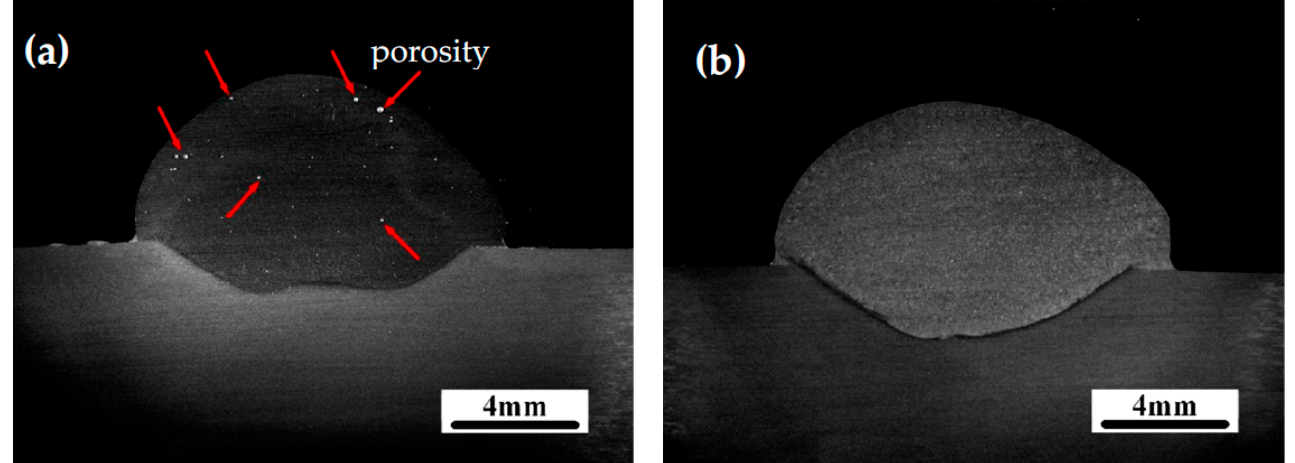
Figure 9. Weld formation for different welding models: ( a ) normal pulse; ( b ) double pulse, 1 Hz; ( c ) double pulse, 3 Hz; and ( d ) double pulse, 5 Hz.